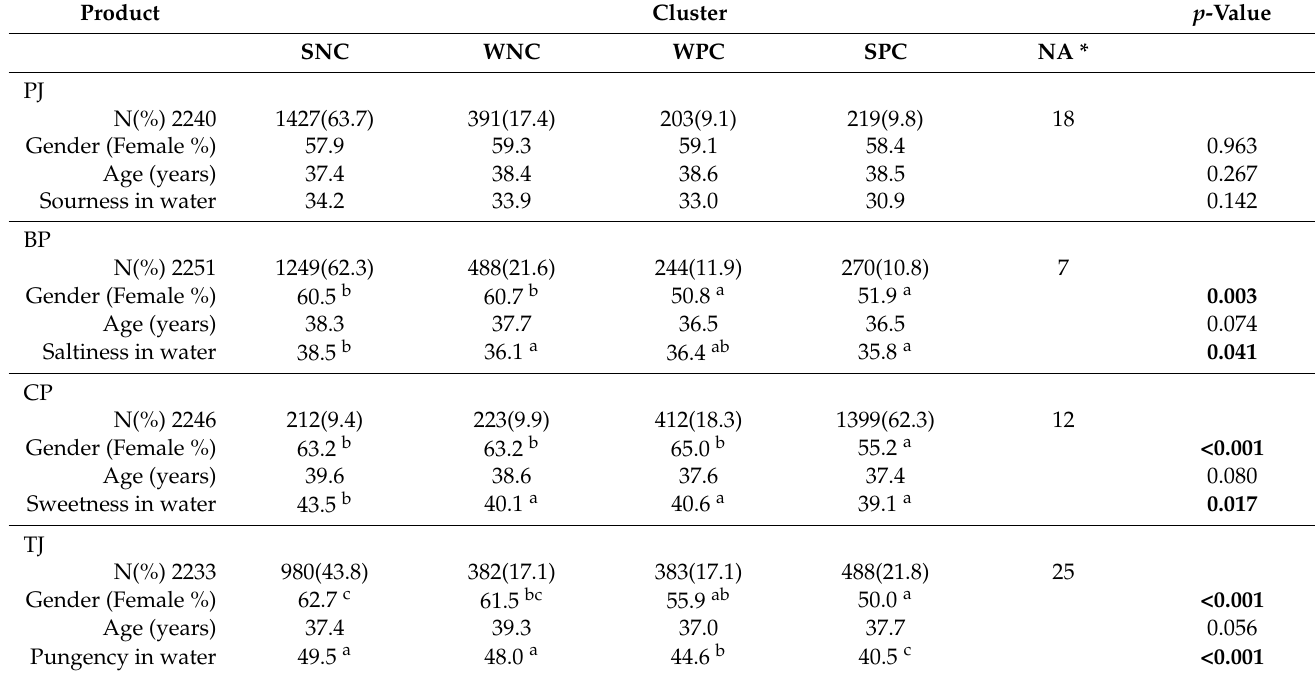
Table 2. For each food model, the sample size (PJ = Pear Juice, BP = Bean Pur é e, CP = Chocolate Pudding, and TJ = Tomato Juice), gender distribution, mean age, and mean perceived target sensation intensity in water are reported for all clusters (SNC = Strong Negative Correlation, WNC = Weak Negative Correlation, WPC = Weak Positive Correlation, and SPC = Strong Positive Correlation). Significant differences are presented in bold ( p < 0.05). Within each row, different letters indicate significant differences between clusters ( p <